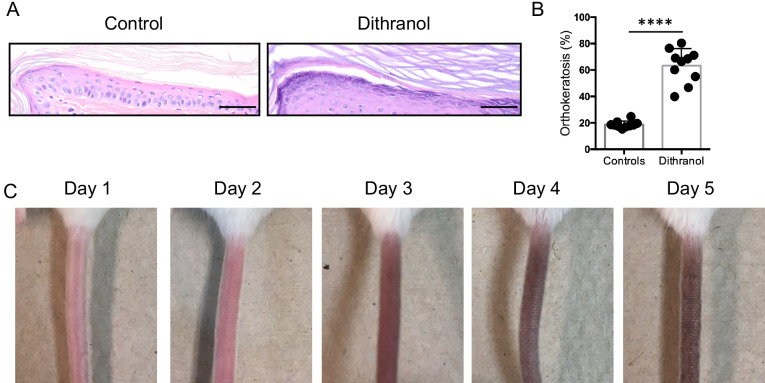
Strong inducing effect of dithranol in the mouse-tail test.(A) Representative H and E images of vehicle-treated and dithranol-treated mouse tail skin. (B) Dithranol treatment significantly increased orthokeratosis. (C) Representative images of erythema and typical brownish discoloration of skin caused by dithranol. Bars represent mean ± SD (n = 10). Mann-Whitney test was used for statistics. *p≤0.05; **p≤0.01; ***p≤0.001; ****p≤0.0001; Scale bar = 50 µm.